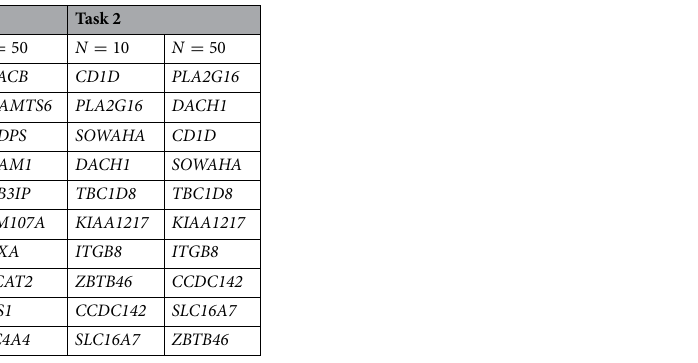
Table 2. Results of gene selection for Task 1 and Task 2.